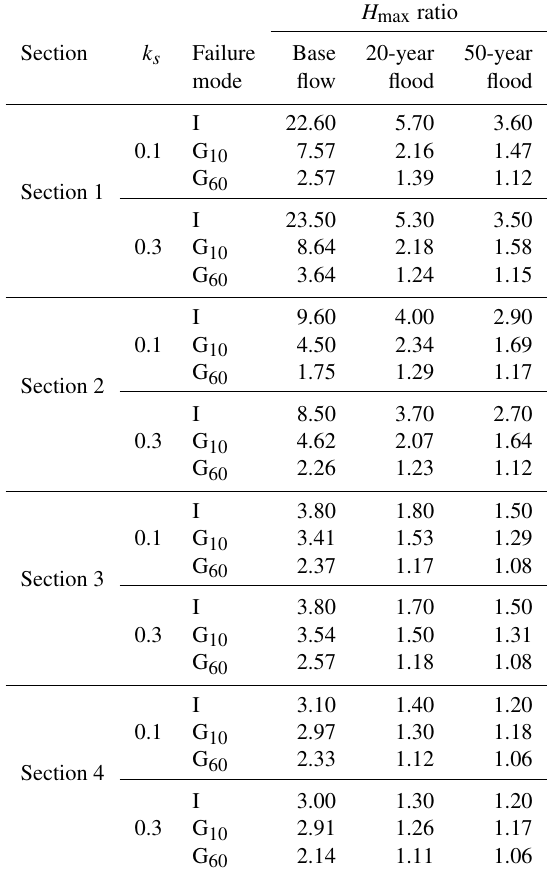
Table 8. Ratio between the maximum water depth ( H max ) fol- lowing dam breaching and the water depth in the pre-failure flow conditions in sections 1 to 4, considering two different roughness heights ( k s = 0.1m and k s = 0.3m) and various pre-failure flows (base flow, 20-year flood and 50-year flood). I and G 10 and G 60 stand for instantaneous, 10min gradual breaching and 60min grad- ual breaching, respectively.